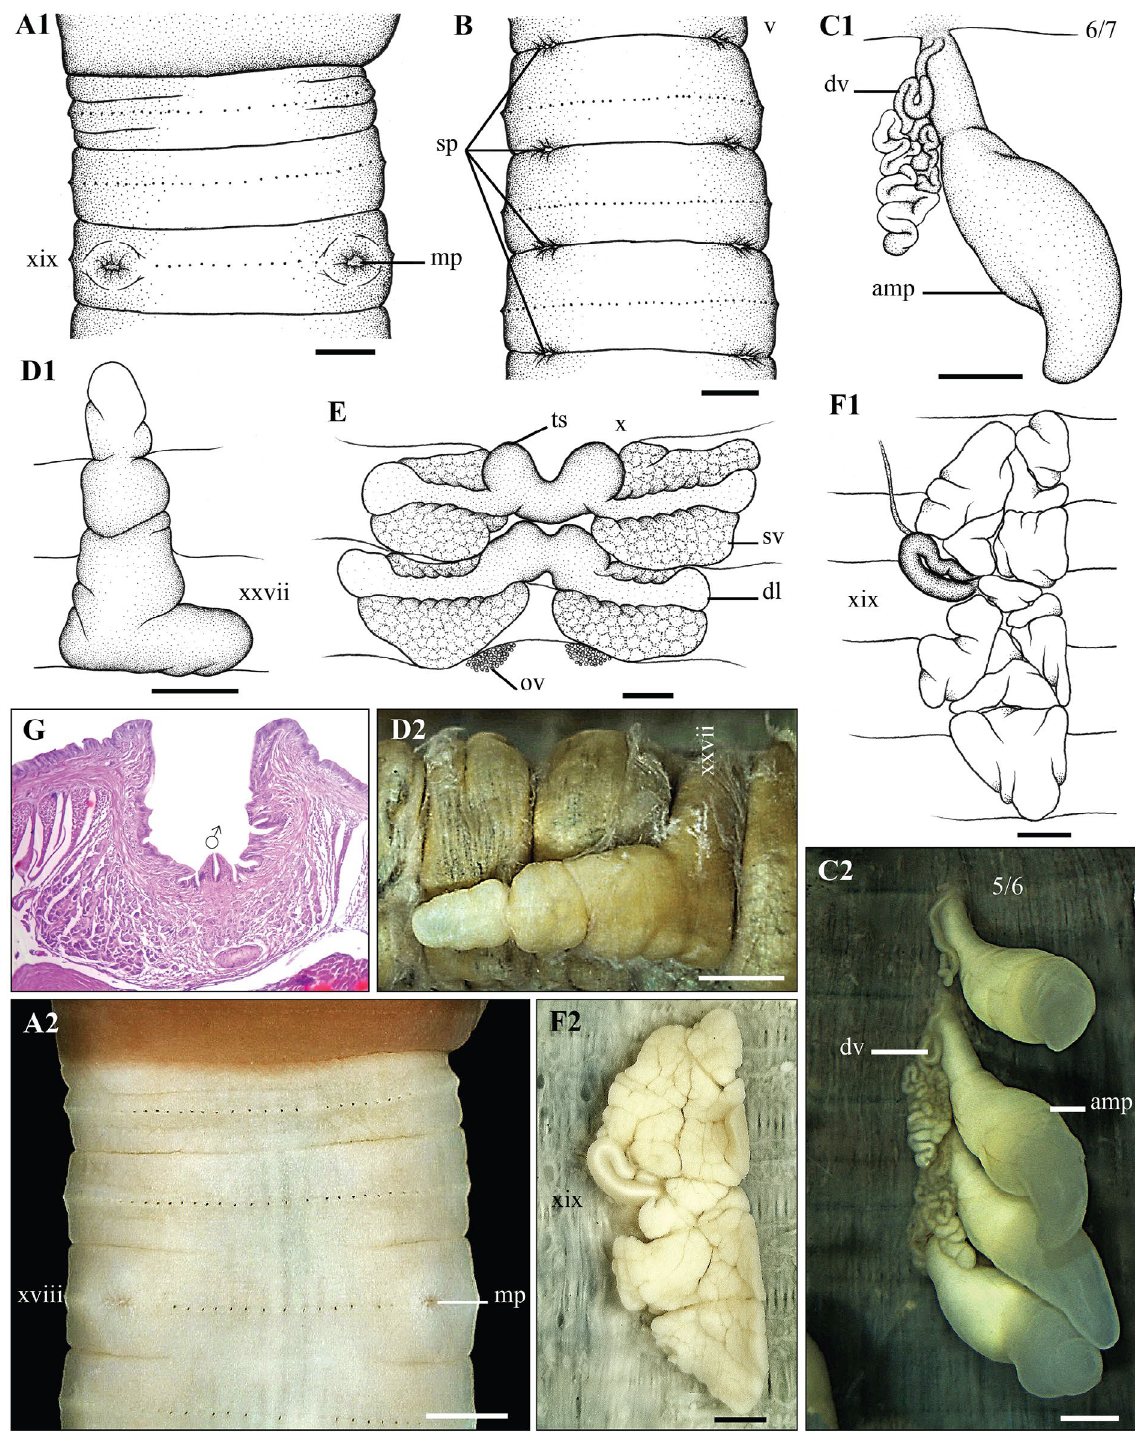
Fig. 1. Metaphire iranomala sp. nov., holotype (CTU-EW.020.h01). A1, A2 . Ventral view of male pores region. B . Lateral view of spermathecal pores region. C1, C2 . Right spermathecae. D1, D2 . Intestinal caecum. E . Testis sacs and seminal vesicles. F1, F2 . Right prostatic gland. G . Copulatory pouch transverse body section. Scale bars = 1